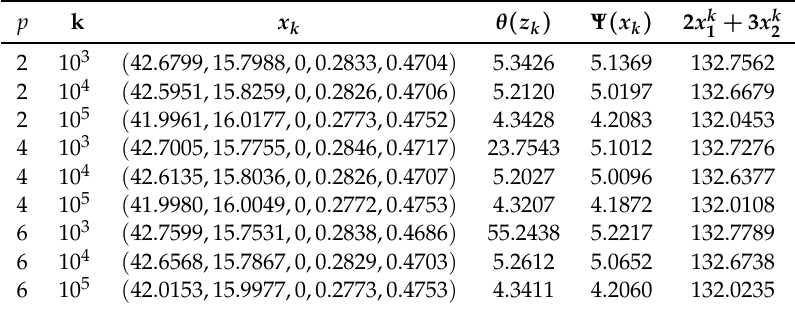
Table 6. Numerical results for Example 3 based on Condition